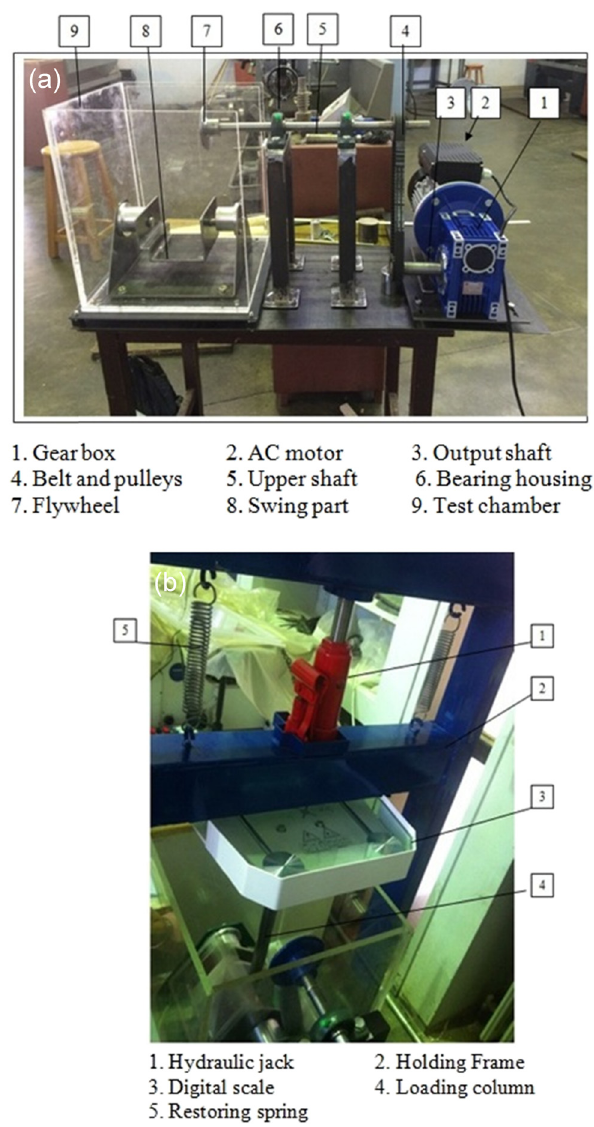
Figure 1: ( a ) Motion generating part of the hip simulator and ( b ) loading unit of the hip